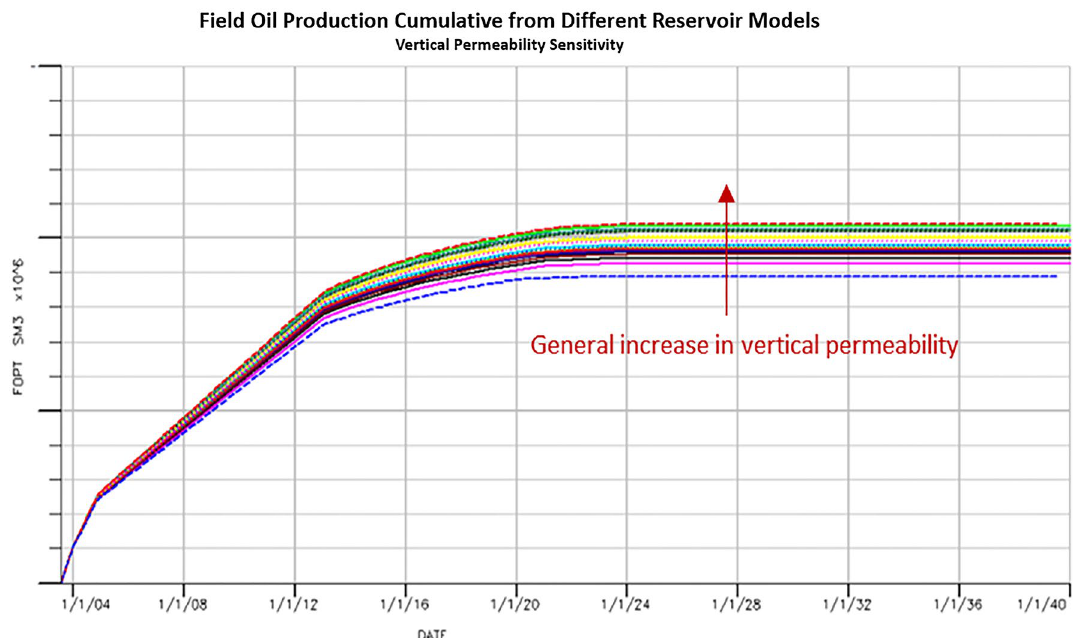
Fig. 4 Impact of reservoir vertical permeability on WAG recovery